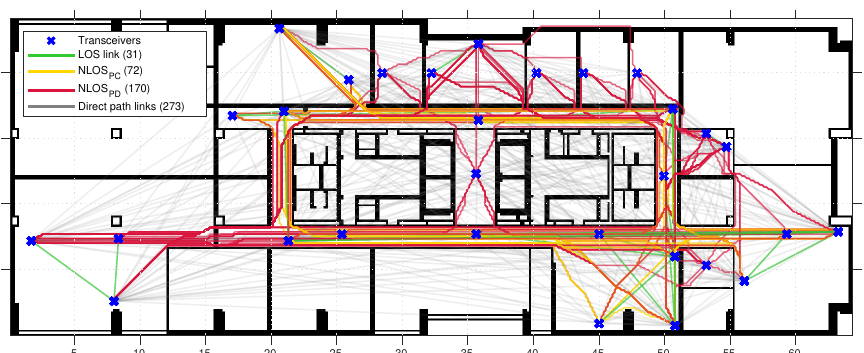
Figure A1. The resulting estimated propagation paths are presented in this figure. The resulting (concatenated) geodesics indicated as paths in green, yellow or red are a result of applying the algorithm in Algorithm 1 to the direct paths indicated as the gray lines.